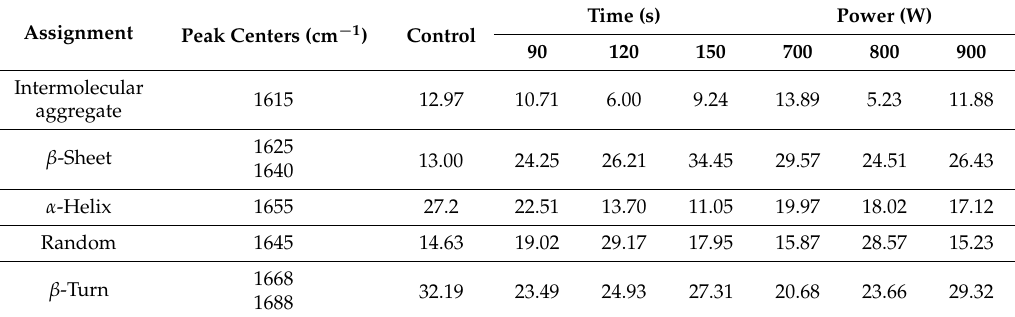
Figure 1. Influence of microwave irradiation power on ( a ) DH and ( b ) the conformation of the lotus protein during enzyme hydrolysis. Table 2. Areas and assignments of the secondary structures in amide I infrared bands from the pretreated proteins.